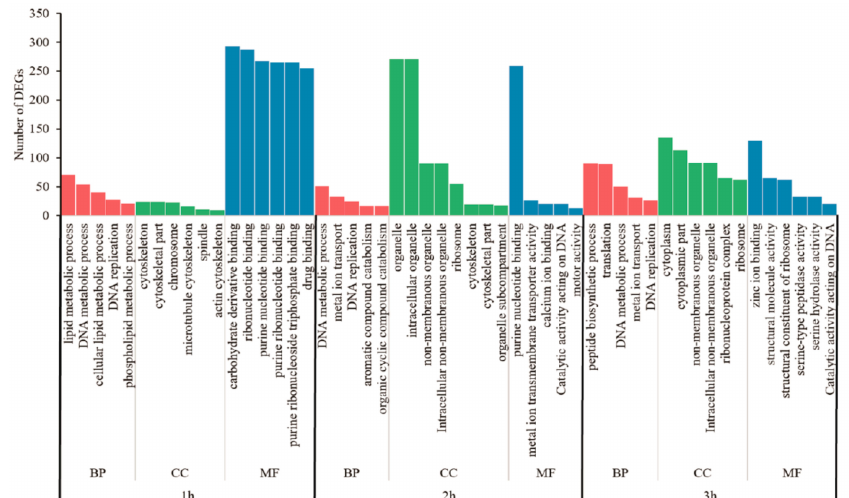
Figure 6. Gene ontology (GO) categorization of DEGs in N. parvum after DSEO treatment. GO analysis was performed for three main categories: biological process (BP), cellular component (CC), and molecular function (MF).